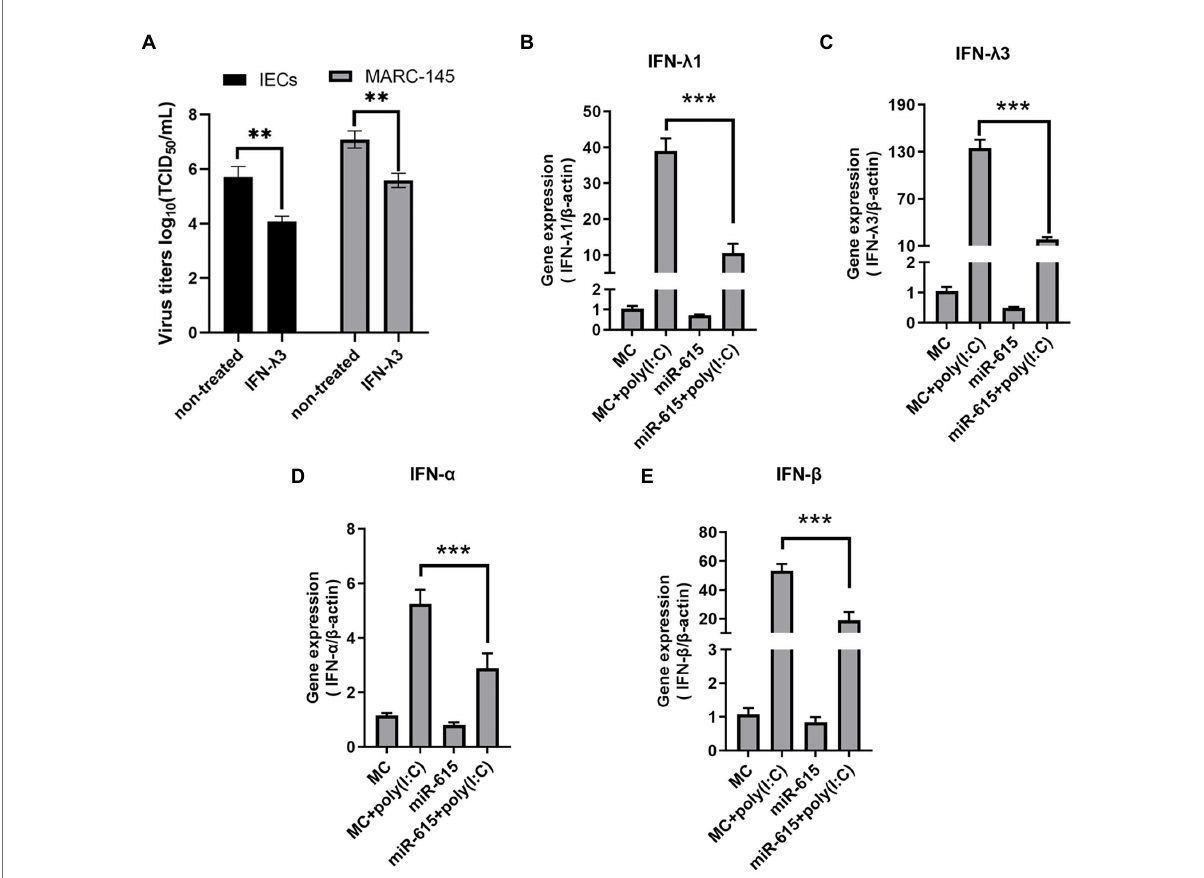
FIGURE 3 miR-615 downregulated the levels of IFN-Is in MARC-145 cells and of IFN-IIIs in IECs. (A) IFN- λ 3 inhibited PEDV replication in IECs and MARC-145 cells. IECs and MARC-145 cells were seeded and treated with 100 ng/ml IFN- λ 3 for 12 h, followed by infection with PEDV at a multiplicity of infection (MOI) of 1 with incubation for 2 h and replenished with fresh infection medium containing the IFN- λ 3. Cell culture supernatants were collected at 12 and 24 h post-infection and titrated to determine the TCID 50 . MARC-145 and IECs were transfected with miR-615 for 24 h and then stimulated with poly (I:C; 10 μ g/ml) for 24 h during PEDV infection. The cells were then harvested for RT-qPCR to determine the levels of (B) IFN- λ 1 and (C) IFN- λ 3 in the IECs, and of (D) IFN- α and (E) IFN- β in MARC-145 cells. The data are representative of three independent experiments (mean ± SD). *** p < 0.001, ** p <